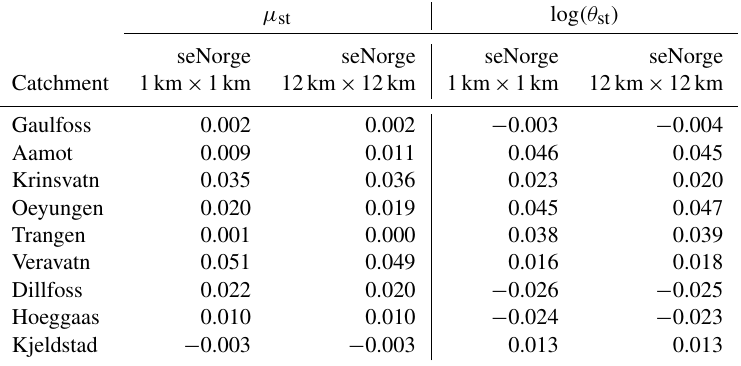
Table 2. The estimated trend coefficient in Eq. (8) for each catchment based on data from 1957 to 1986 for µ st in the probit model (left) and log (θ st ) in the gamma model (right). Estimates are given for both 1km seNorge data and seNorge data upscaled to 12km resolution. µ st